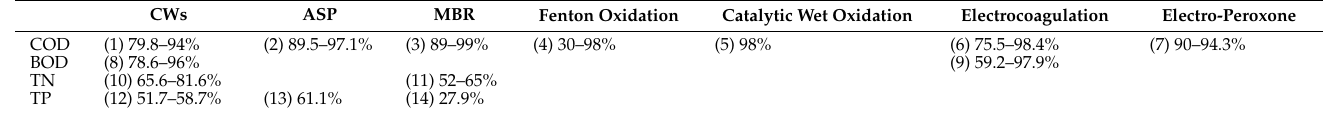
Table 3. Various treatment processes’ rates of conventional water quality indexes concerning drug removal from hospital